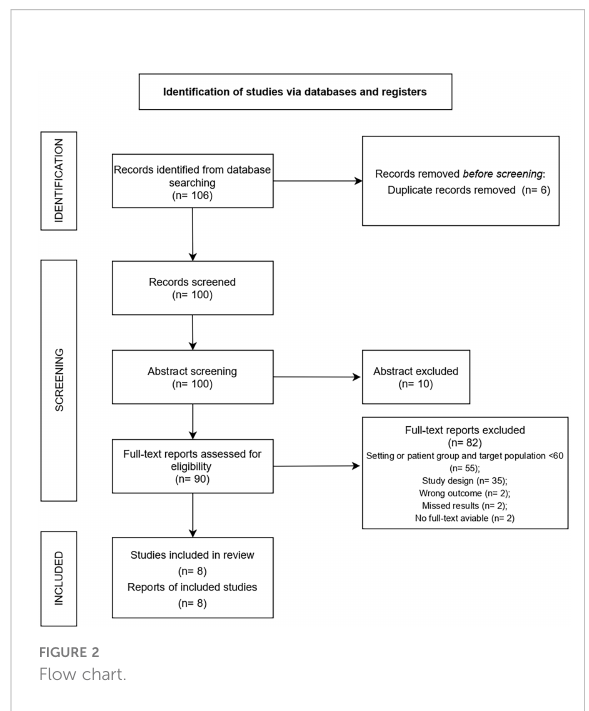
FIGURE 2 Flow chart.